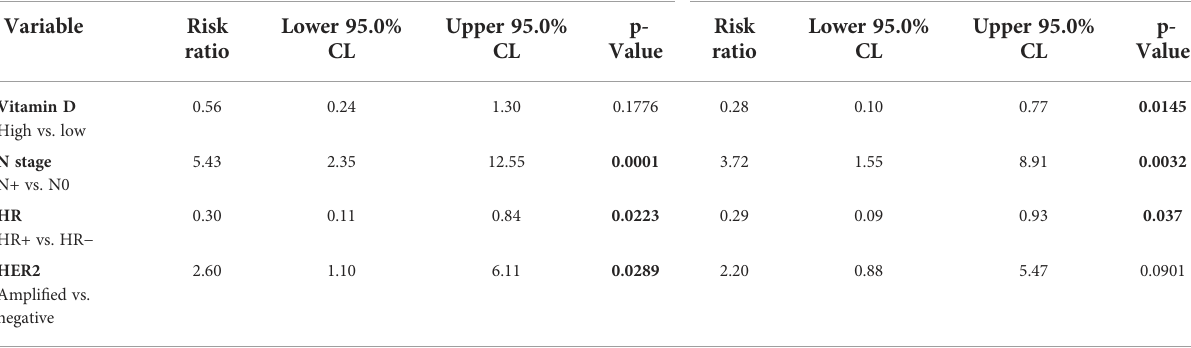
TABLE 4 Multivariate analysis of factors associated with disease-free survival and overall survival. DFS Variable